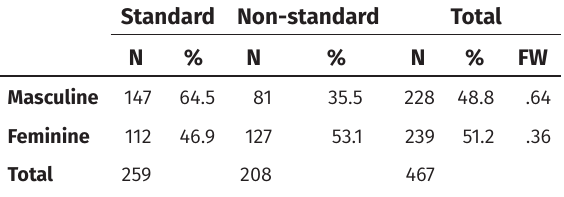
Table 3: Use of standard and non-standard variants according to gender.